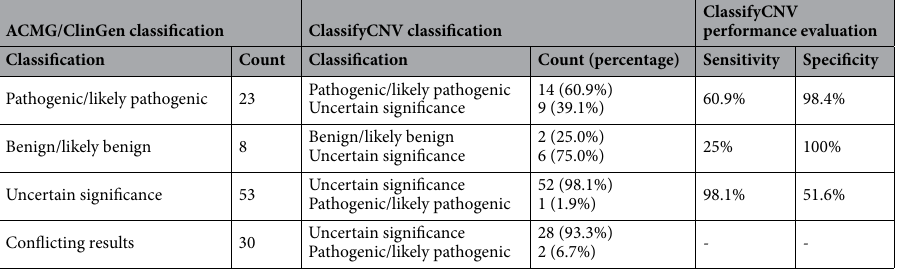
Table 2. Comparison of ClassifyCNV calls to the results of manual annotation by ACMG/ClinGen. For 81% of CNVs, the ClassifyCNV result matched the ACMG/ClinGen result category. ClassifyCNV showed a high degree of specificity for pathogenic/likely pathogenic and benign/likely benign